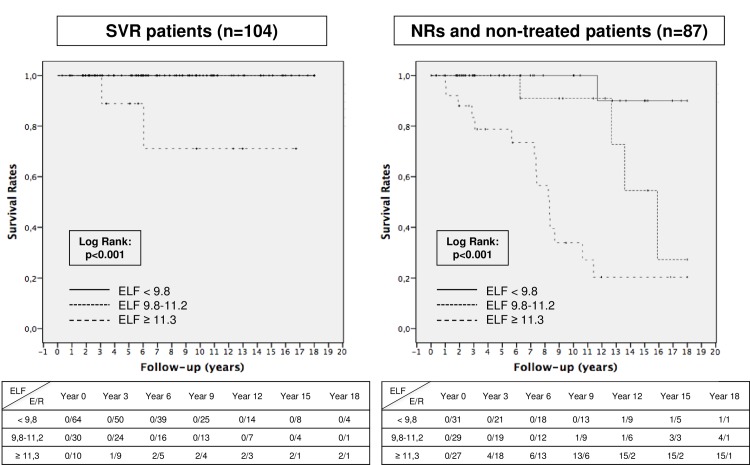
Predictive capacity of the ELF® score to identify clinical events during follow-up usingcryopreserved samples according to HCV-antiviral treatment response (n = 191).Data of number of events (E) and patients at risk (R) in every 3 years time period.